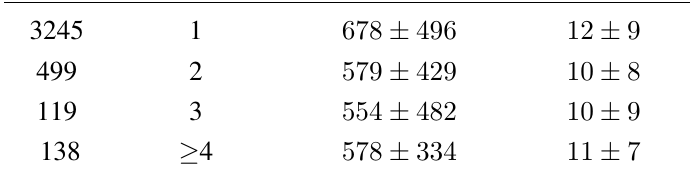
Table 6. Average DFBS surface areas calculated with respect to their number of Pfam domain